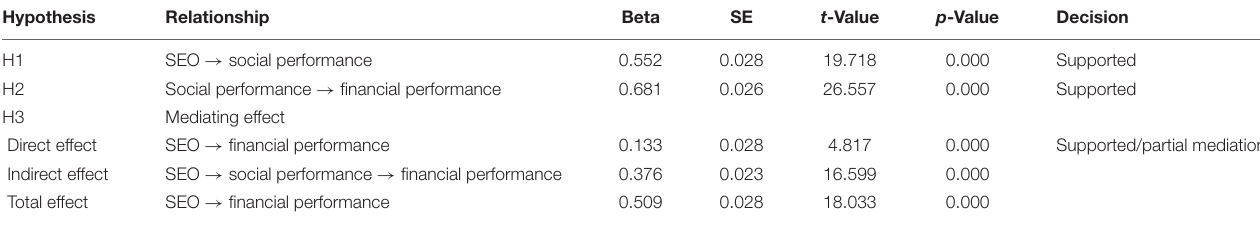
TABLE 7 | Structural